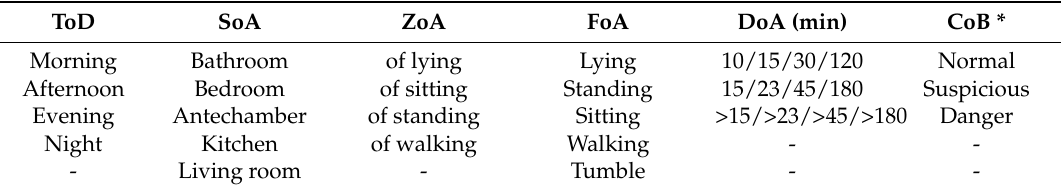
Table 2. Components of the behavior